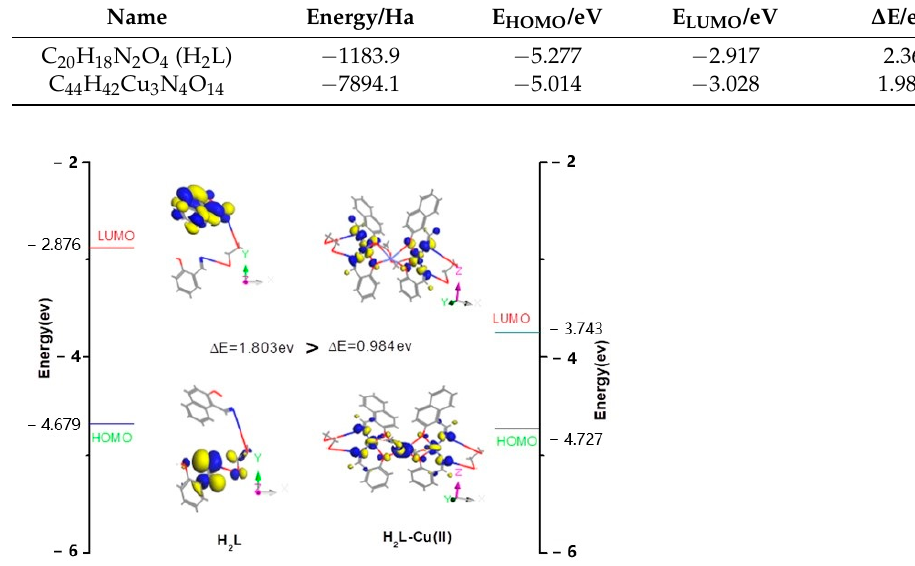
Table 5. Frontier molecular orbital energies and molecule energies of H 2 L and its Cu II complex.